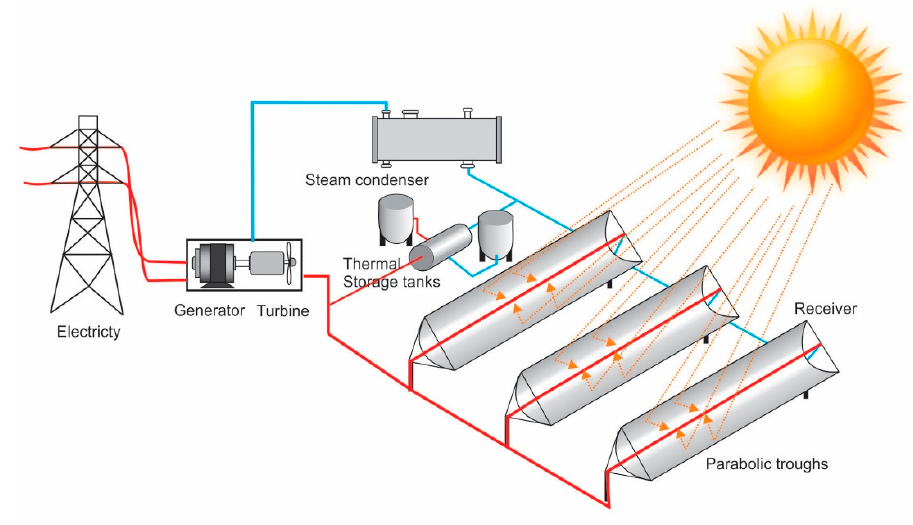
Figure 10. Solar thermal electricity using parabolic troughs.